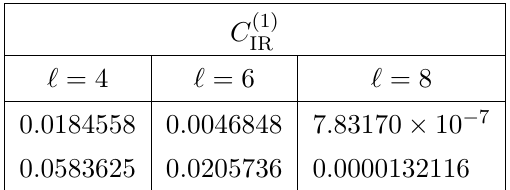
Table 1 . The smallest two numerical values for C (1) displayed in this table correspond to configurations that break all rotational